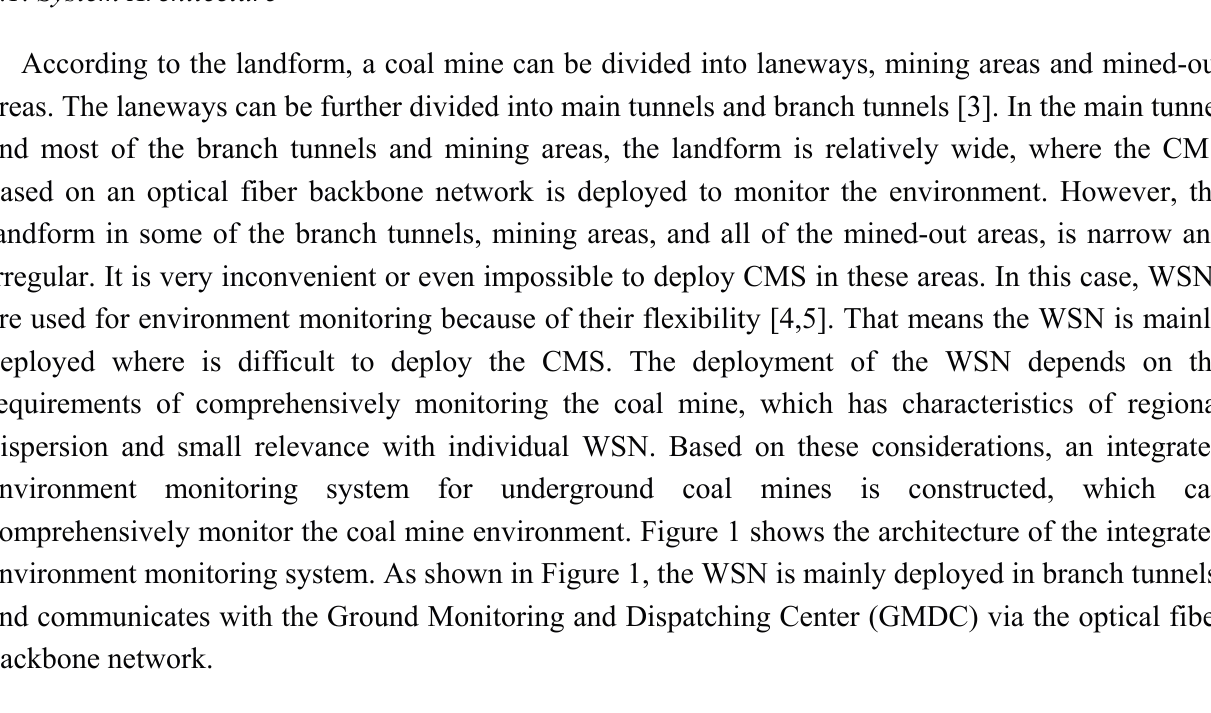
Figure 1. Architecture of the integrated environment monitoring